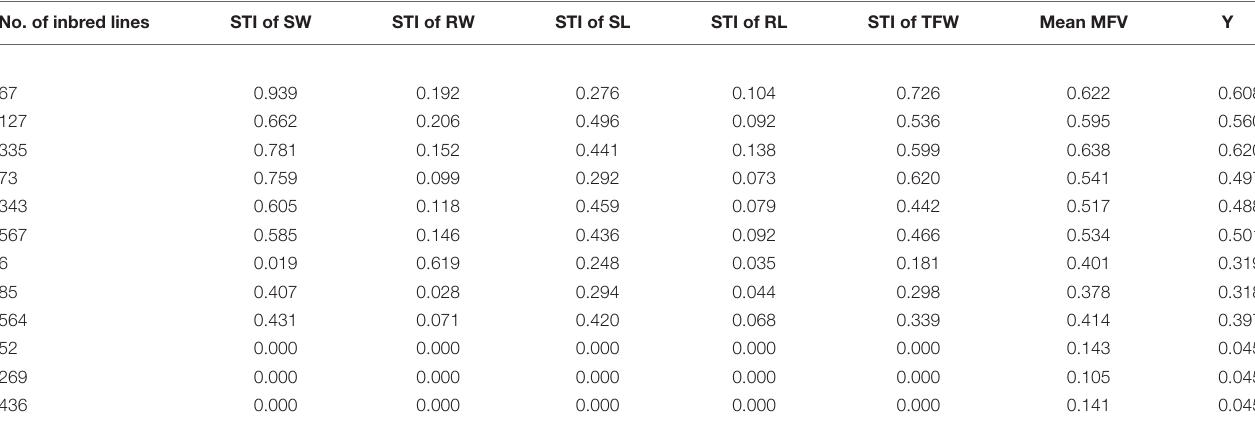
TABLE 3 | Salt tolerance verification of multiple regression analysis with their